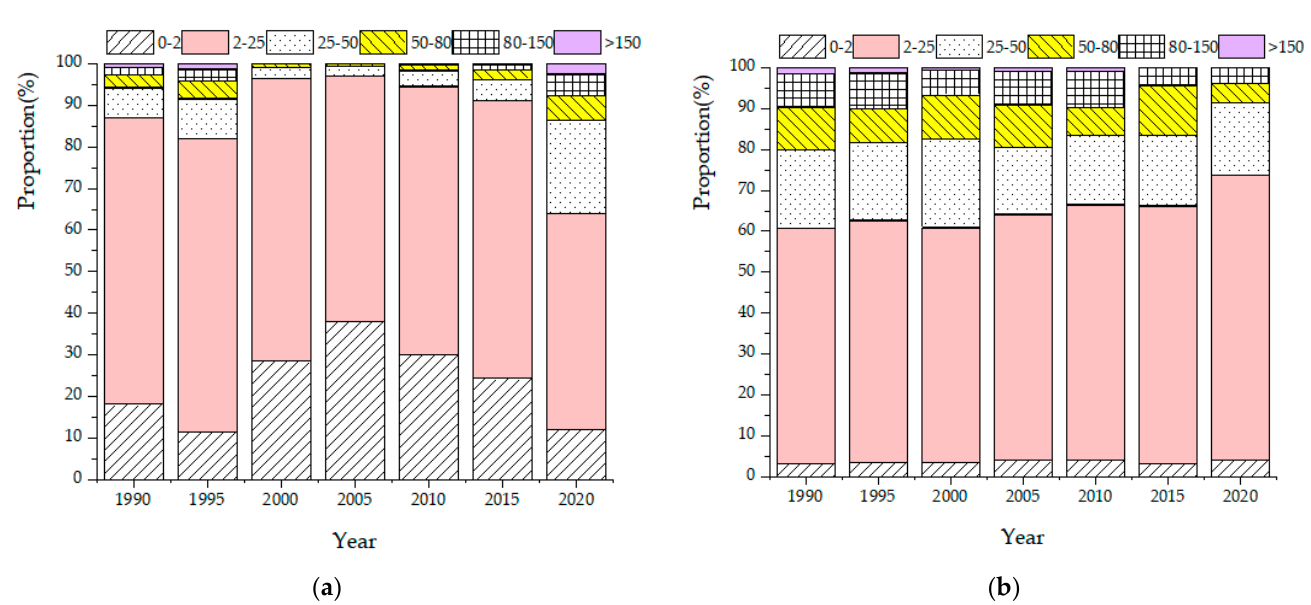
Figure 3. Soil erosion grading map of Baotou City from 1990 to 2020. ( a ) Scale map of soil water erosion grading in Baotou City (%); ( b ) scale map of soil wind erosion grading in Baotou City. Table 2. Soil water erosion intensity transfer matrix in Baotou City.